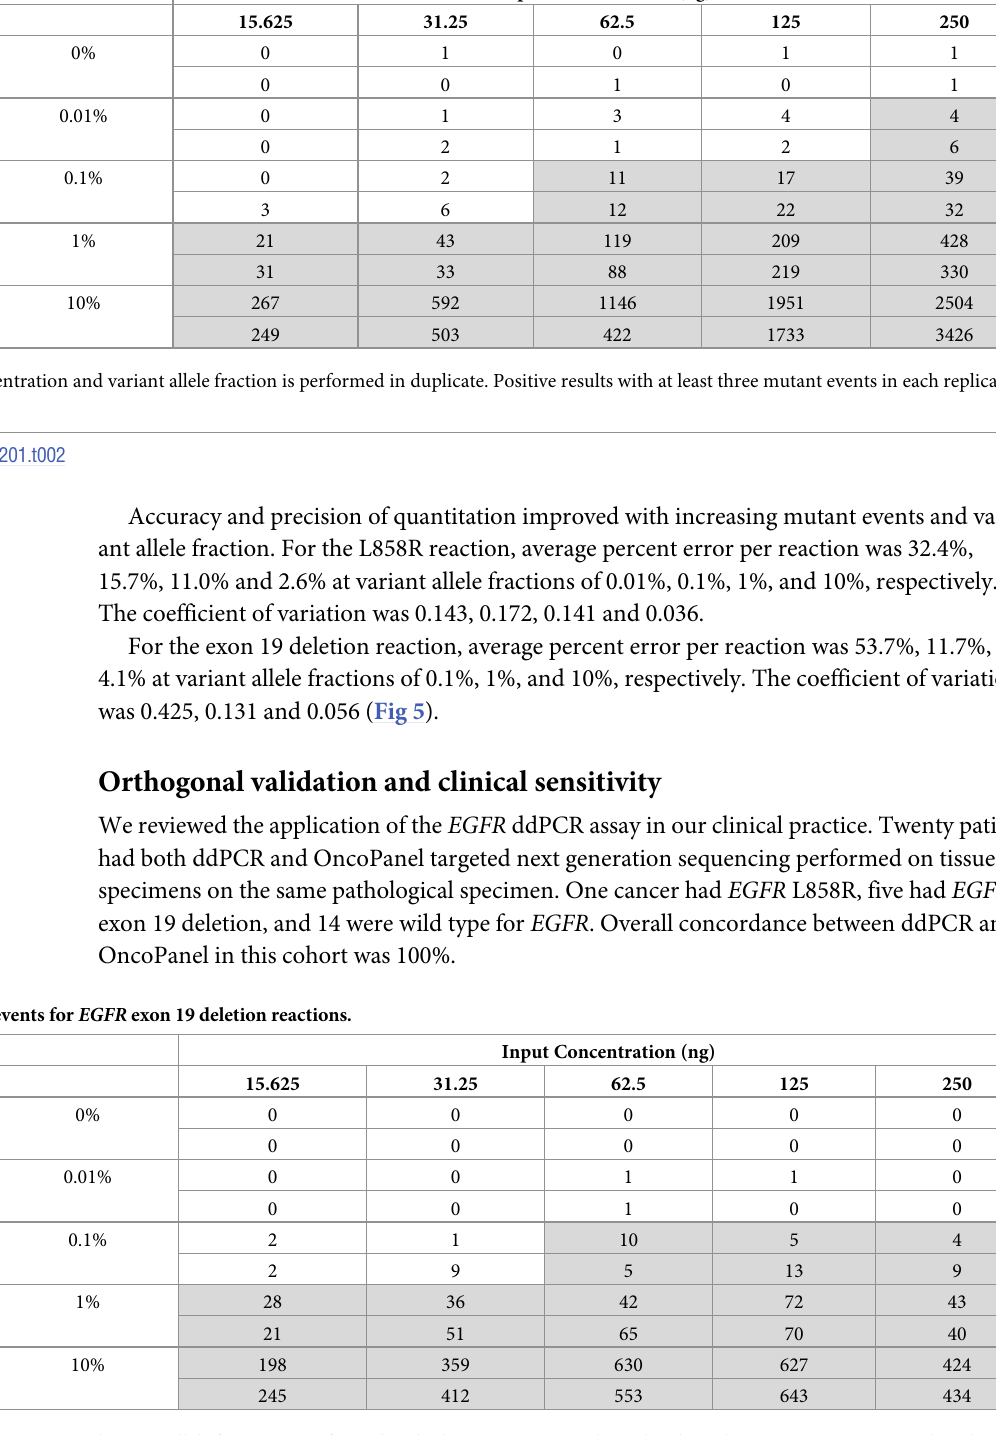
Each combination of DNA input concentration and variant allele fraction is performed in duplicate. Positive results with at least three mutant events in each replicate are highlighted in